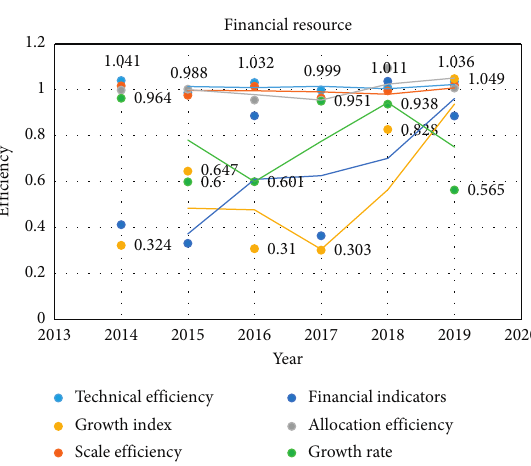
Figure 10: The efficiency of financial resource allocation in recent years. Table 5: Decreased rate of technological progress leads to lower R&D distribution efficiency.